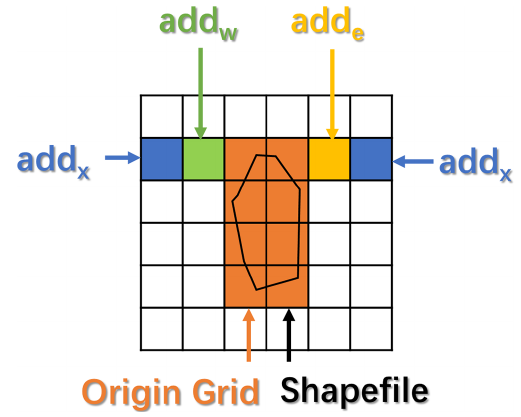
Figure 2. Parameters for modifying the domain in the x